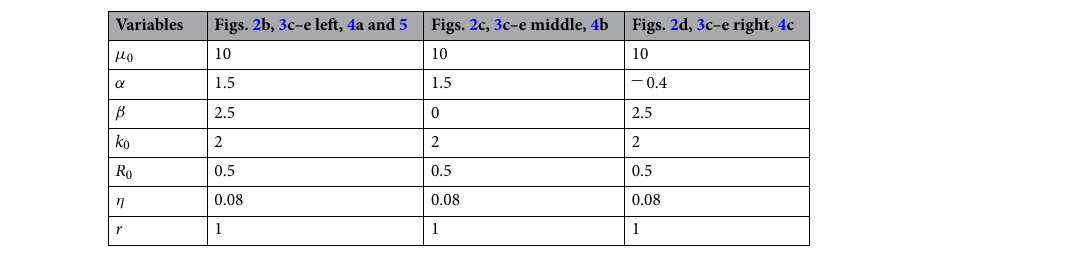
Table 1. List of parameter values.